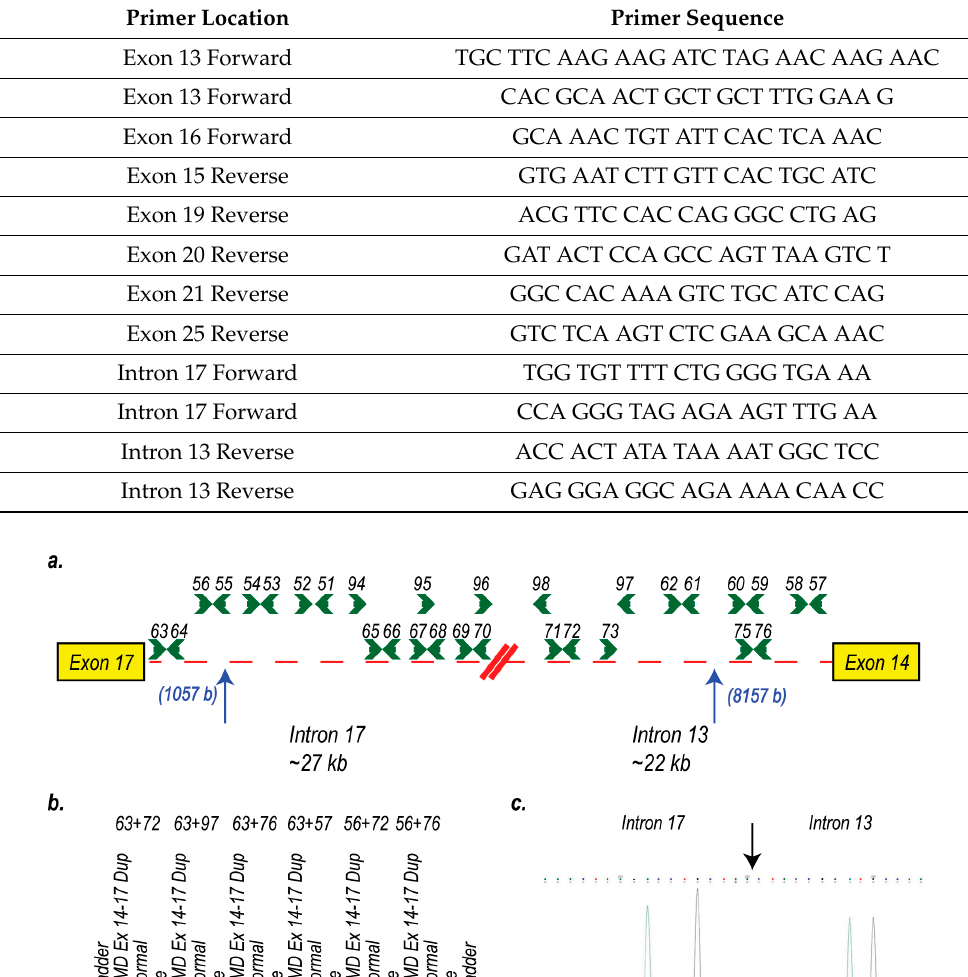
Table 2. Primer Sequences for cDNA synthesis and PCR.